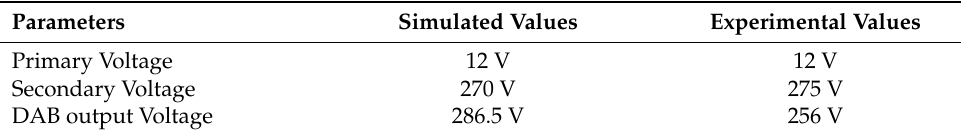
Table 6. Comparison between simulated and experimental